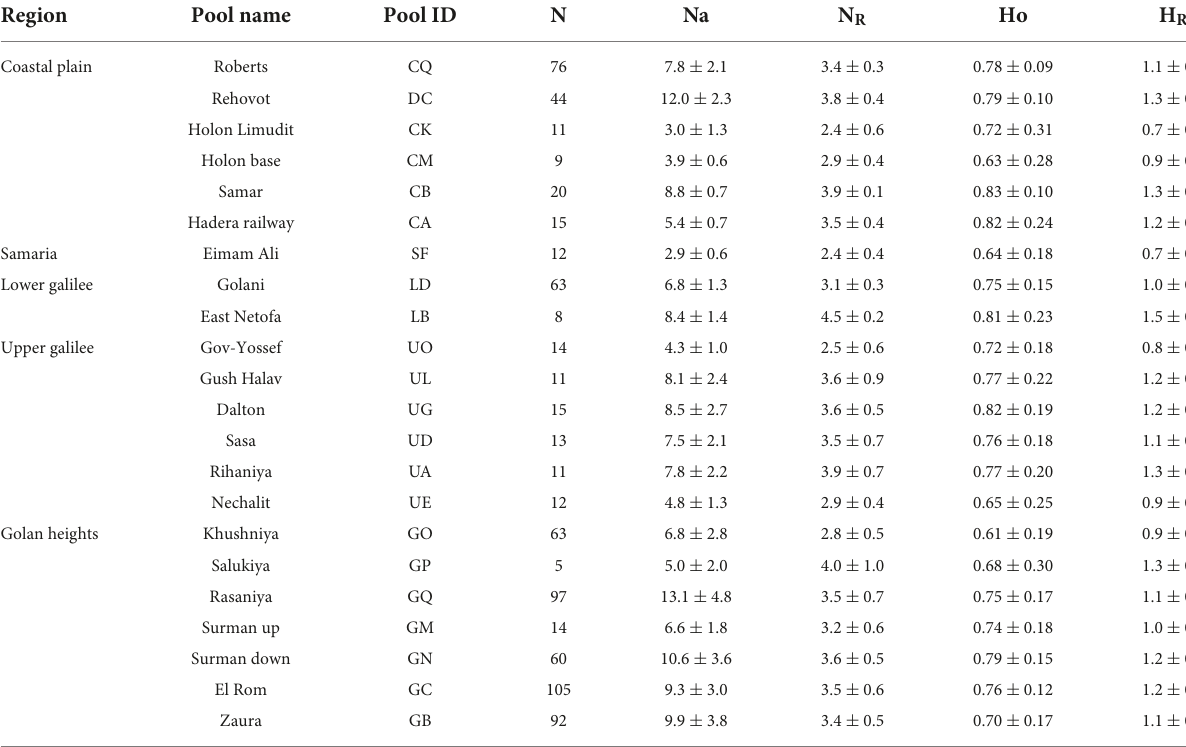
TABLE 1 Genetic diversity measures for the vernal pools sampled in this study. Region Pool name Pool ID